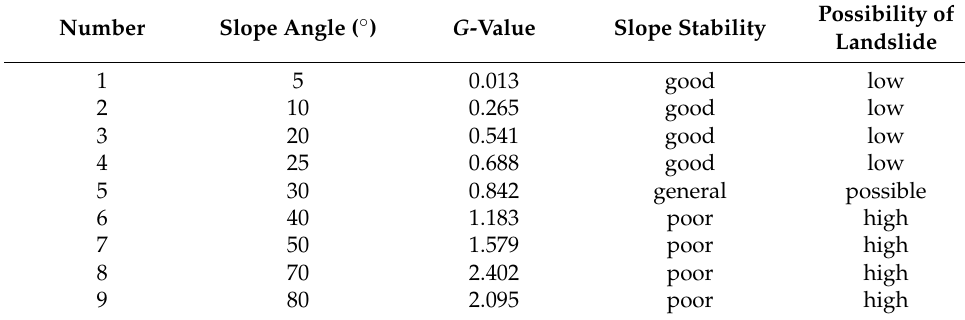
Table 5. Evaluation of different slope